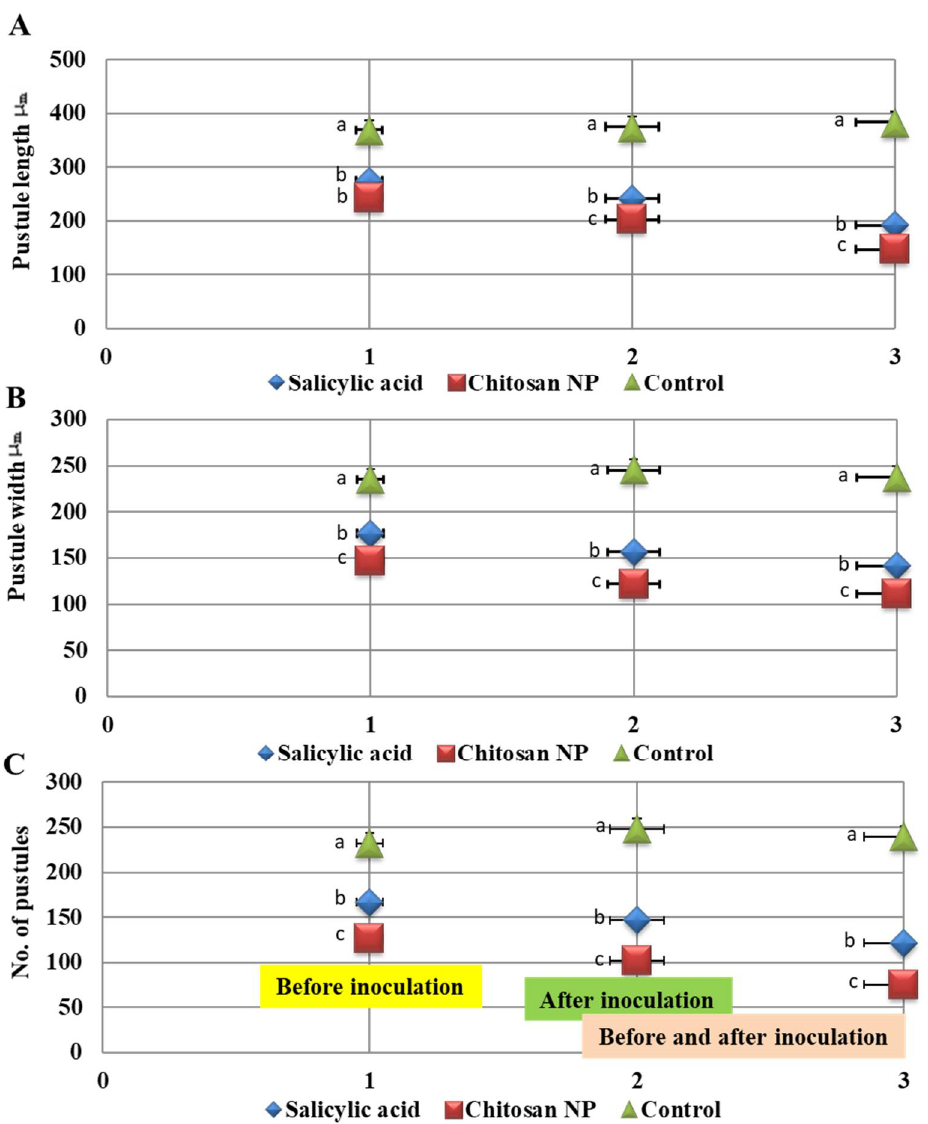
Figure 4. Effect of salicylic acid and chitosan nanoparticles applications (1 = spray before inoculation by 24 h, 2 = spray after inoculation by 24 h and 3 = spray before and after inoculation by 24 h) on pustules length ( A ), pustules width ( B ) and receptivity ( C ). The letters (a, b and c) denote significant difference.